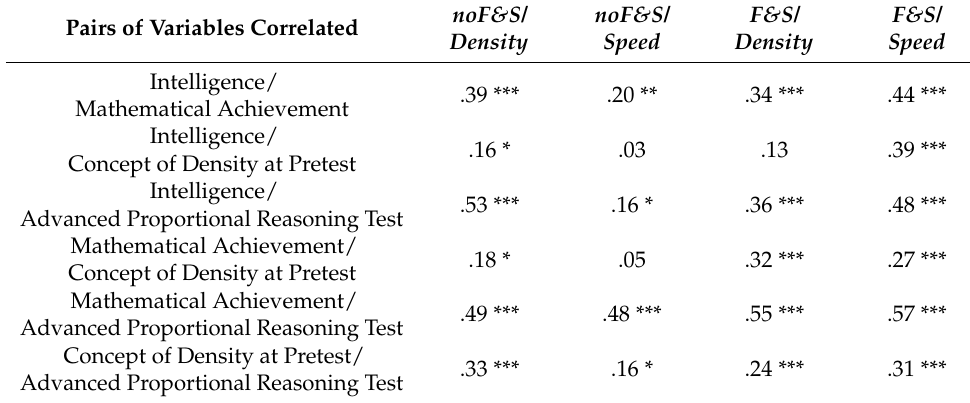
Table 4. Bivariate correlations per group in Study 2.